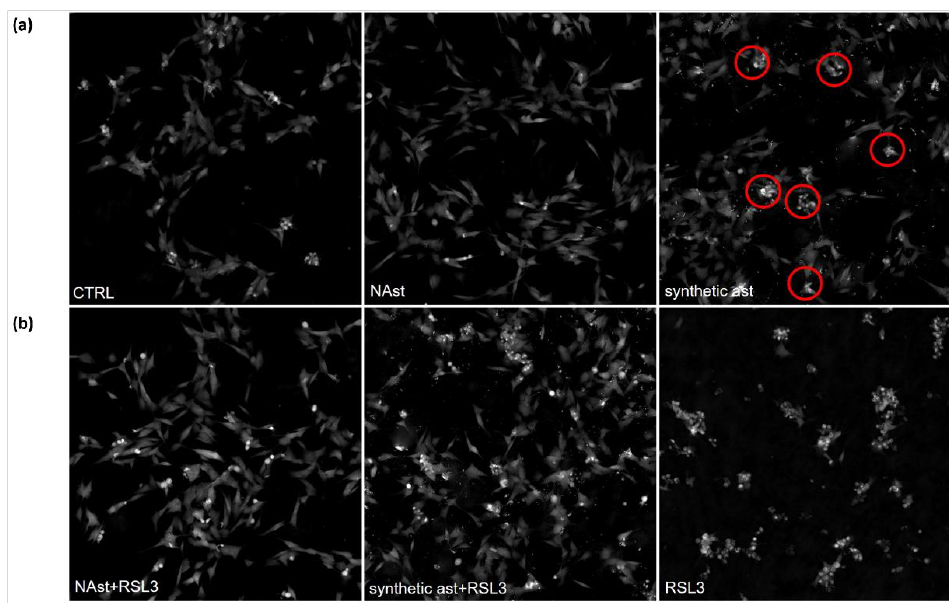
Figure 6. Quantitative phase images of RSL3-treated SHSY-5Y cells in the presence of synthetic and natural astaxanthin. ( a ) Representative images of SHSY-5Y cells pretreated for 24 h with NAst, synthetic ast, and vehicle (ctrl) acquired after 12 h of Livecyte monitoring. Red circles indicate dense cells. ( b ) Representative images of SHSY-5Y cells pretreated for 24 h with NAst, synthetic astaxanthin, and vehicle acquired after 12 h of incubation with RSL3. Scale bar: 200 µm. Treatment with RSL3 induced a strong cytotoxic effect, as shown in Figure 6b. The pretreatment with natural or synthetic astaxanthin showed a protective effect; strikingly, NAst exerted a higher protective effect than the synthetic one, as evidenced by the lower number of small and thickened cells. To deeply investigate this phenomenon, some mo- tility parameters were analyzed, such as instantaneous velocity, track speed, and displace- ment. As shown in Figure 7a,b, cells exposed to RSL3 presented lower mobility in compar- ison to the controls; when cells were pretreated with natural and synthetic astaxanthin, the exposure to RSL3 did not induce any changes in cell motion parameters. Moreover, plots of cell displacement for random migration studies were obtained in the same conditions. This metric represents the distance a cell migrates relative to its point of origin and also considers the degree to which a cell meanders from its starting point to its end point. The cell displacement graphs shown in Figure 7c suggested that SHSY-5Y cells pretreated with natural or synthetic astaxanthin and exposed to RSL3 did not migrate farther from their points of origin than the control cells. On the contrary, RSL3-treated cells, without astaxanthin preincubation, showed lower displacement, indicating an al- tered mobility pattern.